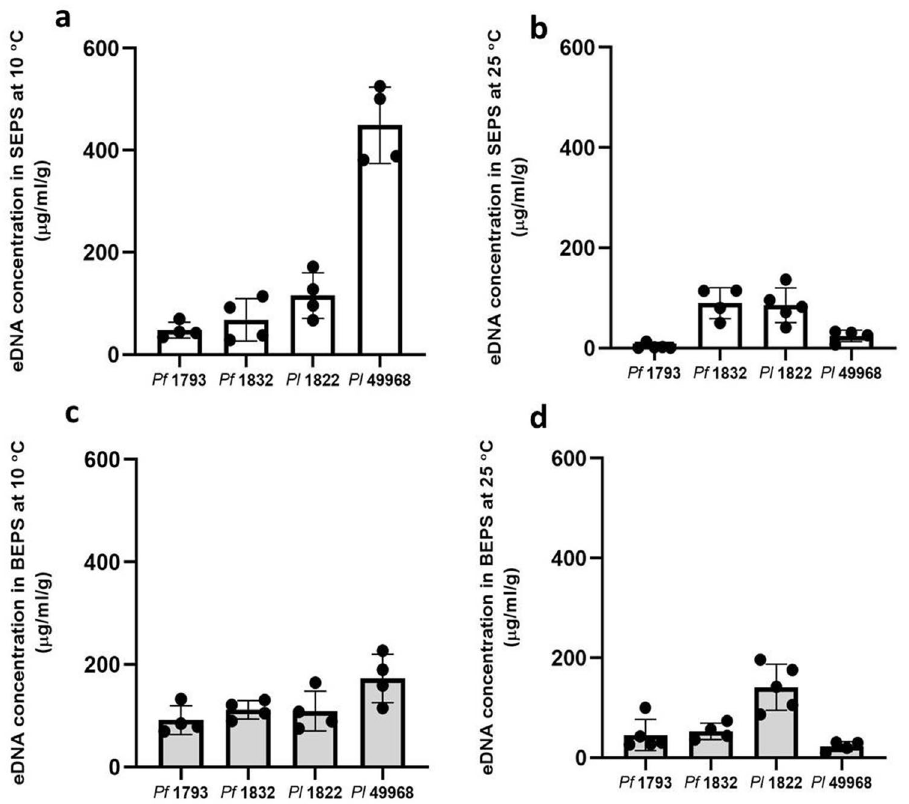
Figure 6. The eDNA content of the soluble and bound fractions of matrix EPS. The eDNA content of four biological replicates of P. fragi (1793, 1832) and P. lundensis (1822, ATCC 49968) biofilms formed on nitro- cellulose membrane placed on meat at 10 °C ( a , c ) and 25 °C ( b , d ). Error bars show the standard deviations from four biological replicates. Statistical differences were evaluated through one-way ANOVA, with a confidence level of 95% ( P <